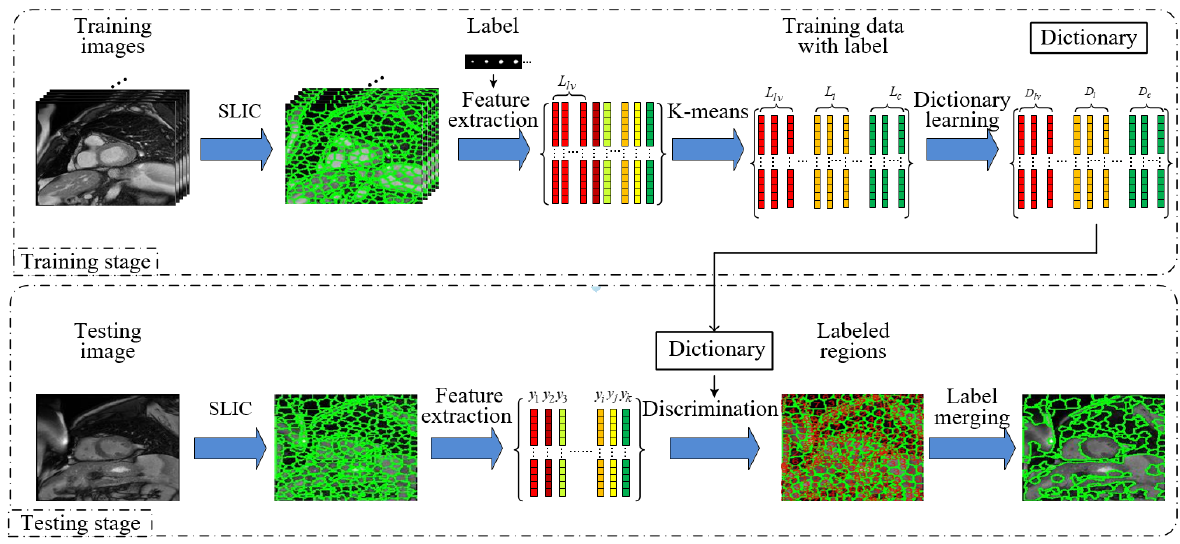
Figure 4. Block diagram of candidate region generation module. In the training stage, the seven sub-dictionaries are trained by seven types superpixel regions. In the testing stage, the discriminative dictionary is proposed to classify the segmented superpixel regions and fuse the same label areas to generate left ventricular candidate